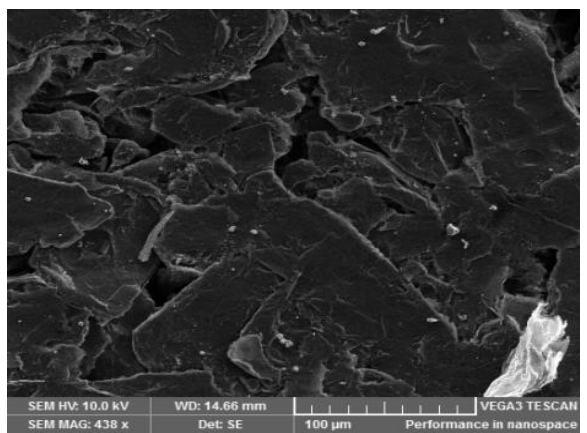
Figure 4. A Scanning Electron Microscope (SEM) image of the Graphene Nano-Platelets (GNPs) (100µm).